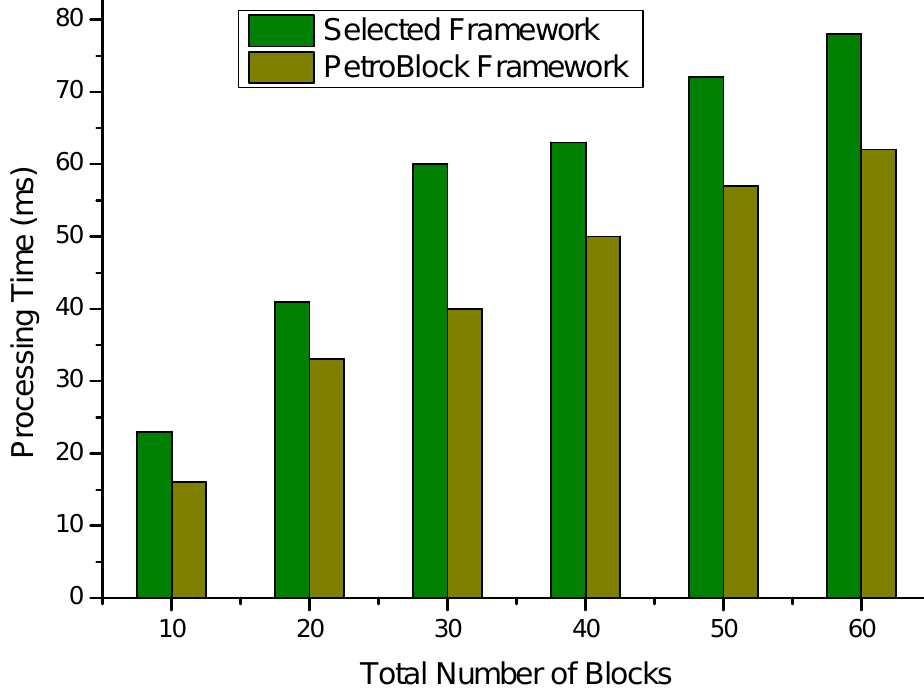
Figure 17. Processing overhead comparison